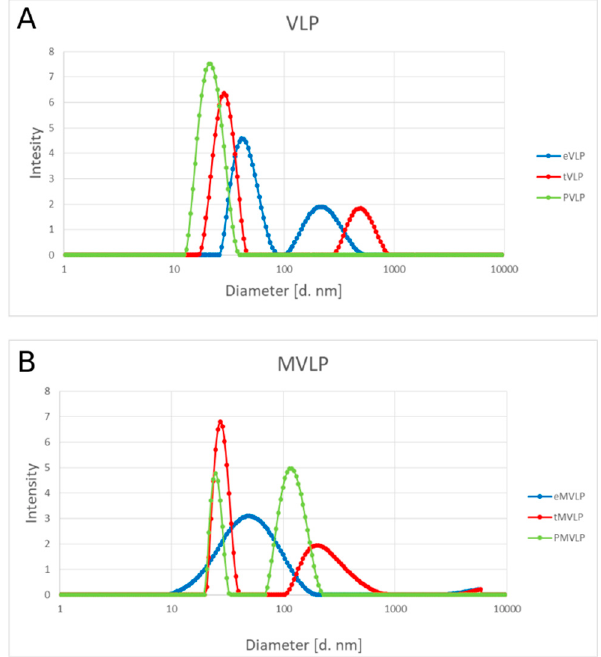
Figure 7. Size distribution of BMV-based VLPs in sodium acetate buffer (pH 4.8) and 25 °C by dynamic light scattering (DLS). Wild-type VLPs ( A ) and mutated VLPs ( B ). Empty VLPs are in blue, VLPs with tRNA are in red, and VLPs with PSS are in green.